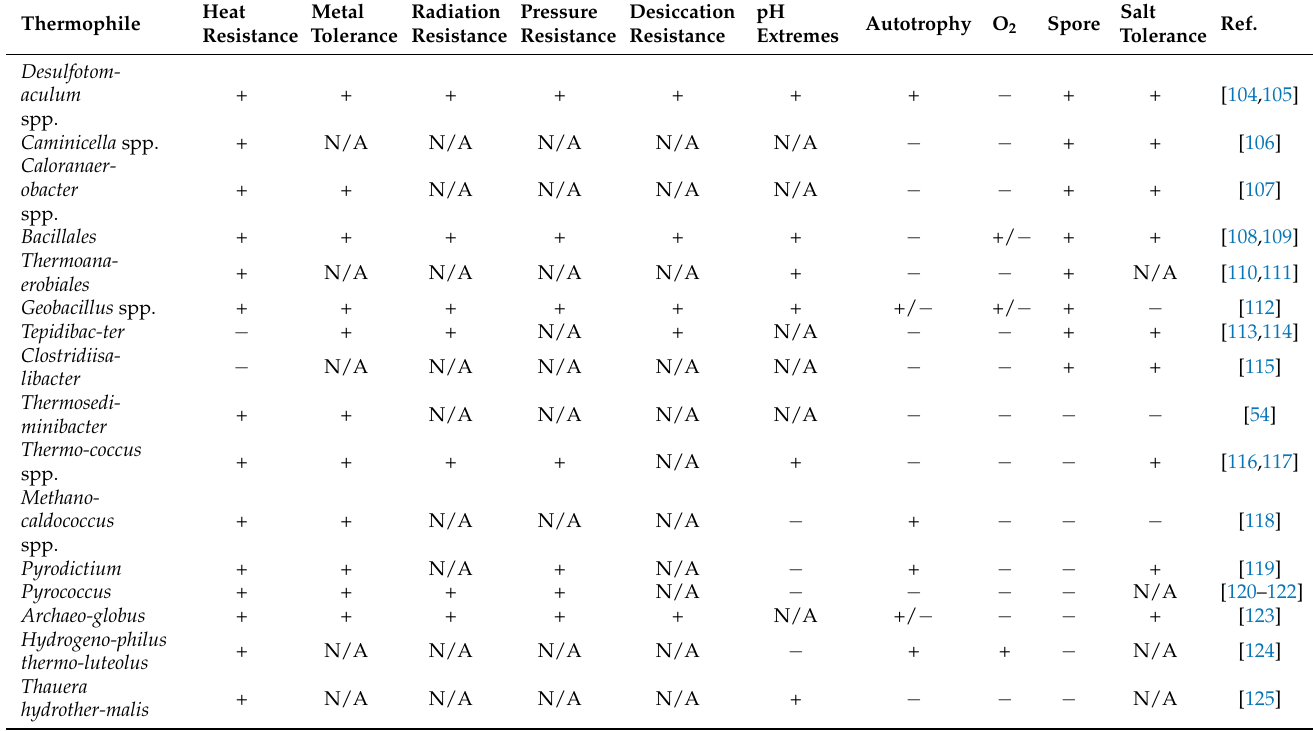
Table 2. Extremophilic properties of “freezing thermophiles” presented in Table